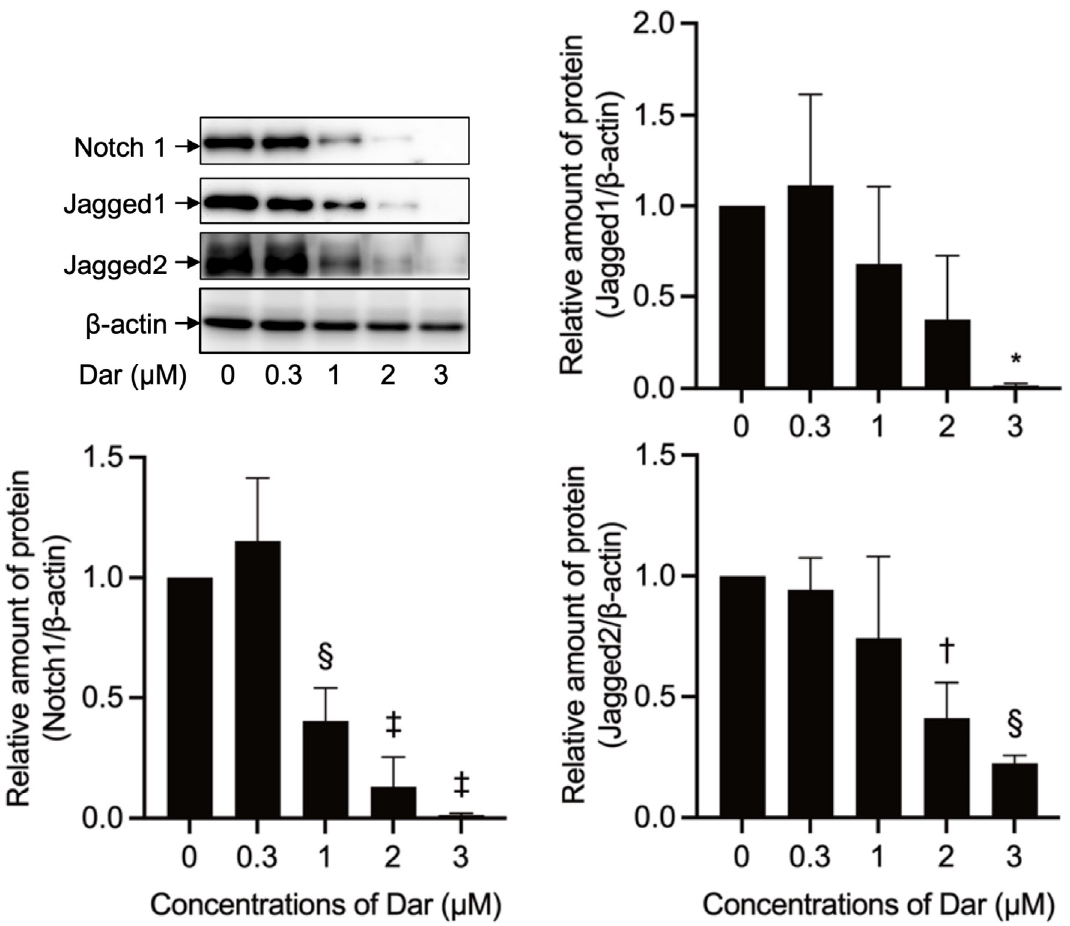
Figure 10. Effect of darinaparsin on Notch1 signaling ‐ related gene protein expression. Following treatment with various concentrations of darinaparsin (0.3, 1, 2 and 3 μ M) for 24 h, the alteration of expression levels of Notch1 signaling ‐ related proteins was analyzed using Western blot. Representative images of the expression profiles of each protein are shown from three independent experiments. The relative expression levels are expressed as the ratios between each gene protein and β‐ actin protein expression levels and are compared with those of untreated control group. Results are shown as the means ± SD from three independent experiments. *, p < 0.05; †, p < 0.01; §, p < 0.001; ‡, p < 0.0001 vs. control. Dar, darinaparsin. The images of beta ‐ actin are identical to those in Figure 3D because the same experiment samples were used for analysis.